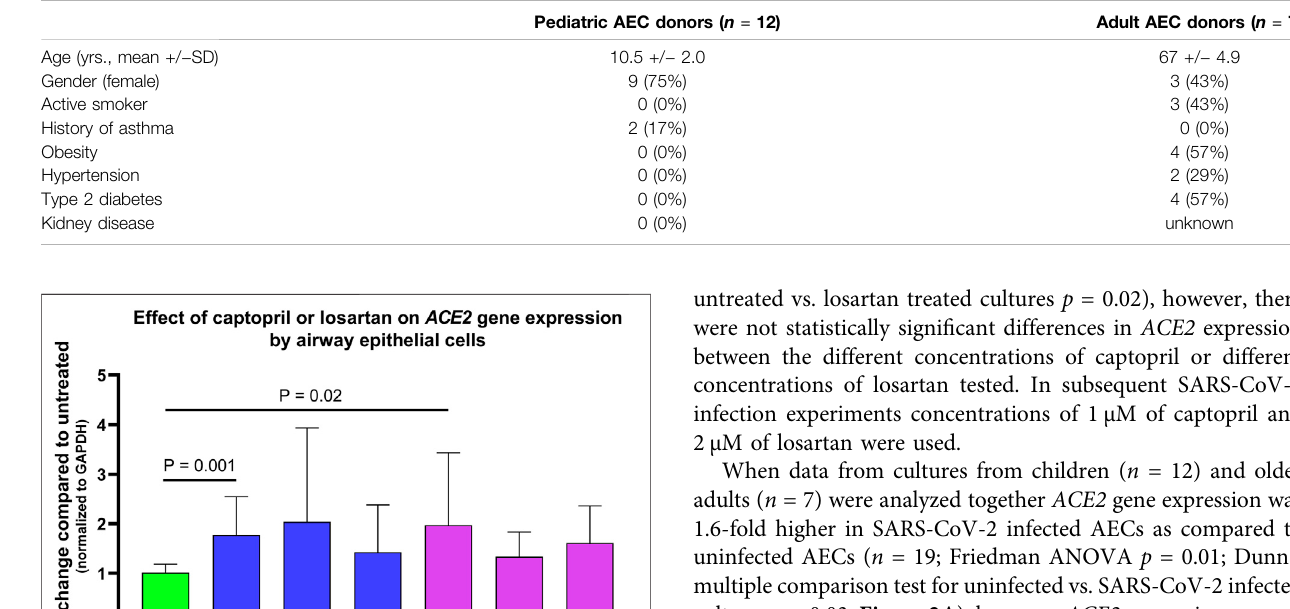
TABLE 1 | Demographics and clinical characteristics of AEC donors.